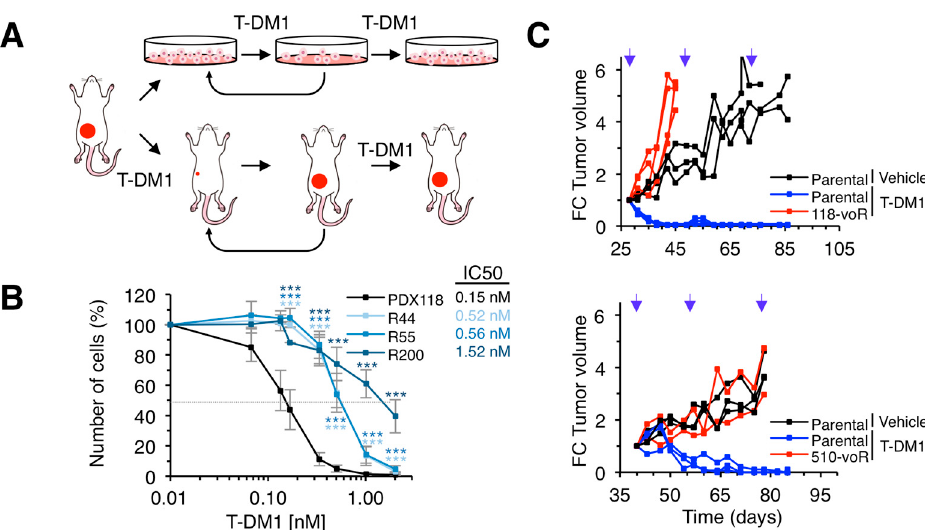
Figure 2. Generation of in vitro and in vivo models of acquired resistance to T-DM1. ( A ) Schematic drawing illustrating the strategies to generate in vitro and in vivo resistant models from PDXs. ( B ) The indicated cell cultures were treated with increasing concentrations of T-DM1 for 6 days. Cell numbers were estimated by crystal violet staining. Dashed grey line indicates 50% survival and IC50 is shown next to figure legend. Averages and standard deviation of six independent experiments are represented. ** p < 0.01, *** p < 0.001, two ‐ tailed Student t test. ( C ) NOD/SCID mice carrying the indicated parental PDXs or the resistant PDXs obtained in vivo as shown in A were treated and analyzed as described in Figure 1D.